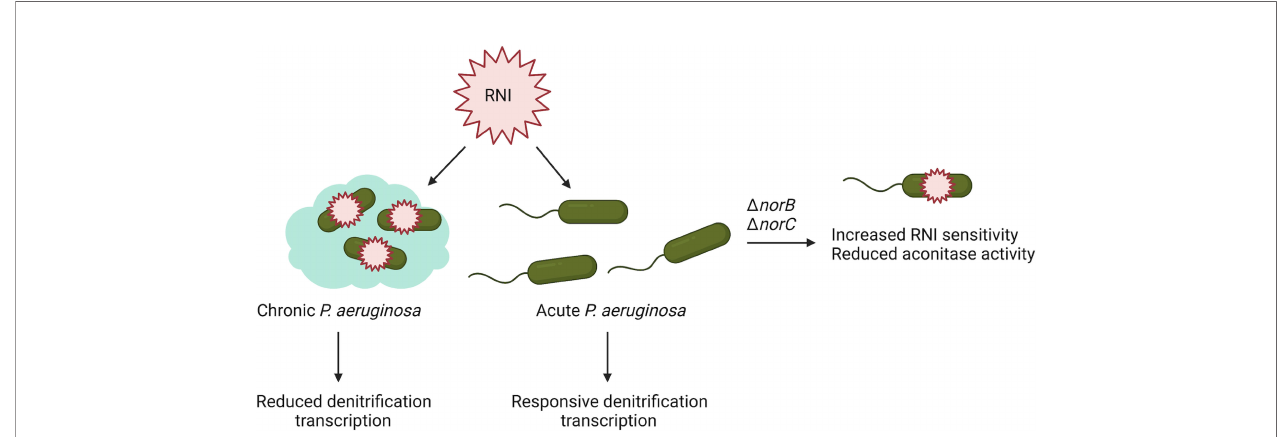
FIGURE 6 | Proposed model showing altered denitri fi cation expression renders chronic P. aeruginosa isolates more susceptible to commensal-mediated RNI. Chronic CF isolates of P. aeruginosa have increased sensitivity to RNI compared to acute or environmental isolates of P. aeruginosa , which may be in part due to altered expression of denitri fi cation genes. Additionally, loss of norB and norC in an acute background recapitulates enhanced RNI sensitivity that is observed in chronic